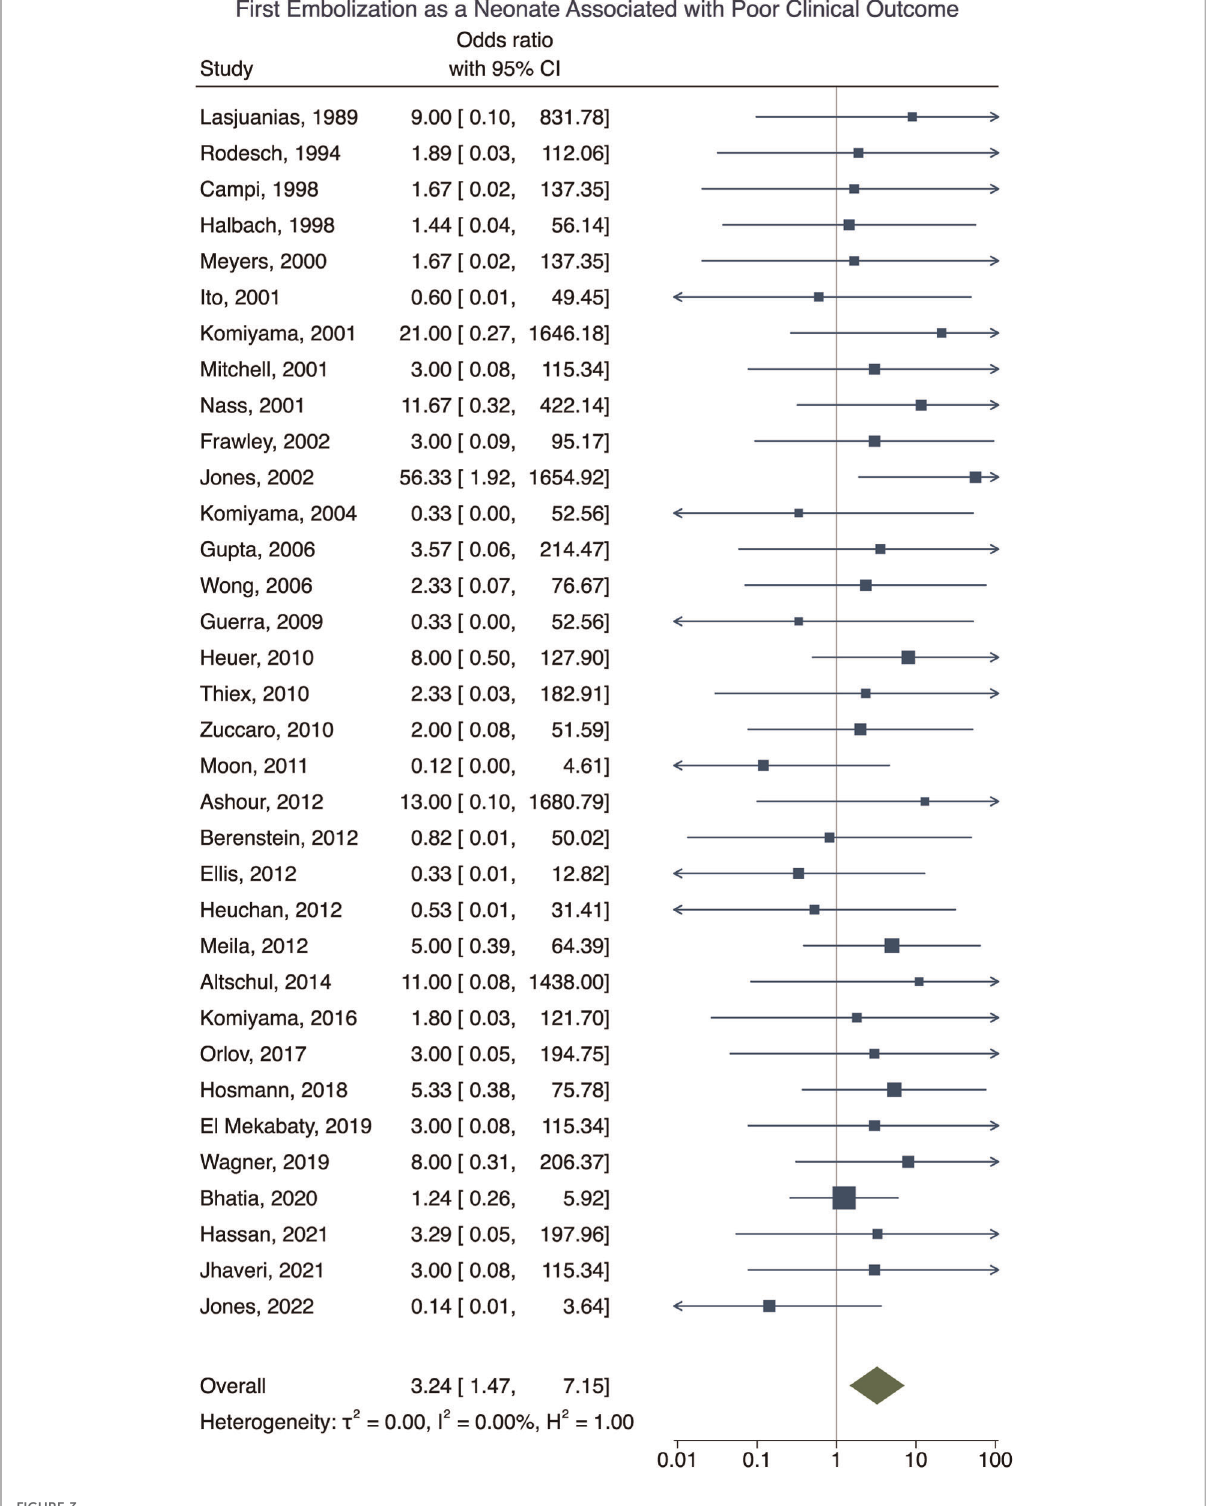
FIGURE 3 Forest plot of the association of fi rst embolization as a neonate with poor clinical outcome after VOGM embolization.